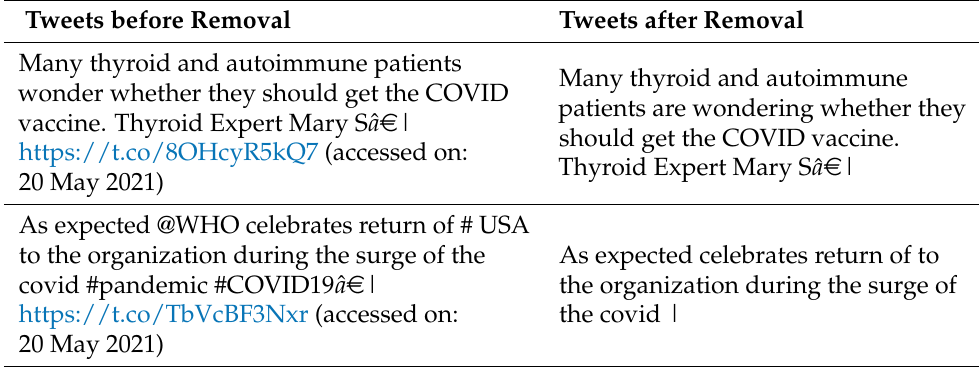
Table 2. Data after removal of username, hashtags, and hyperlinks.